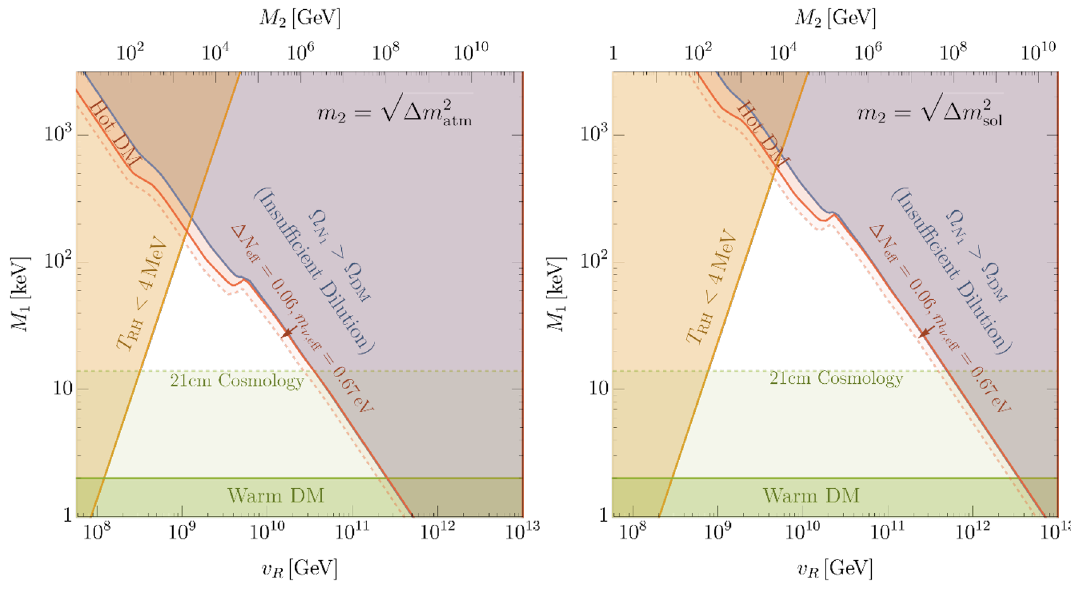
Figure 2 . The parameter space of N 1 DM produced by relativistic freeze-out and dilution from N 2 decay in terms of the Left-Right symmetry breaking scale, v R , and the mass of N 1 , M 1 . We show constraints from N 2 decaying after Big Bang Nucleosynthesis ( orange ), decaying too early to provide sufficient N 1 dilution ( blue ), warm DM bounds ( green ), and hot DM bounds ( red ). In addition we show prospects of improved searches for hot DM from CMB telescopes (dashed red ), and warm DM from 21 -cm cosmology (dashed green ). We fix the ν 2 mass with the at- √ mospheric neutrino mass difference, m 2 = ∆ m 2 , left , and the solar neutrino mass difference, √ atm m 2 = ∆ m 2 , right sol